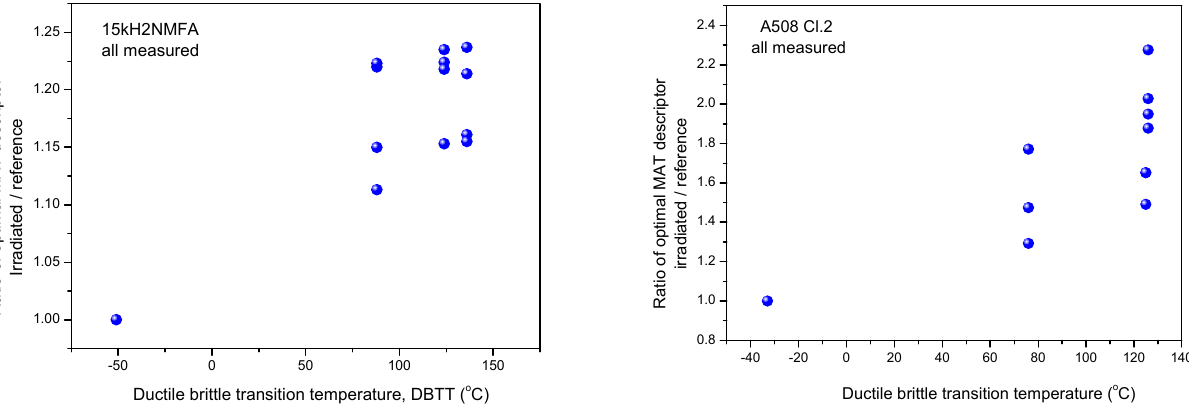
Figure 6. Normalized MAT descriptor vs. transition temperature for all 15kH2NMFA and A508Cl.2 samples.